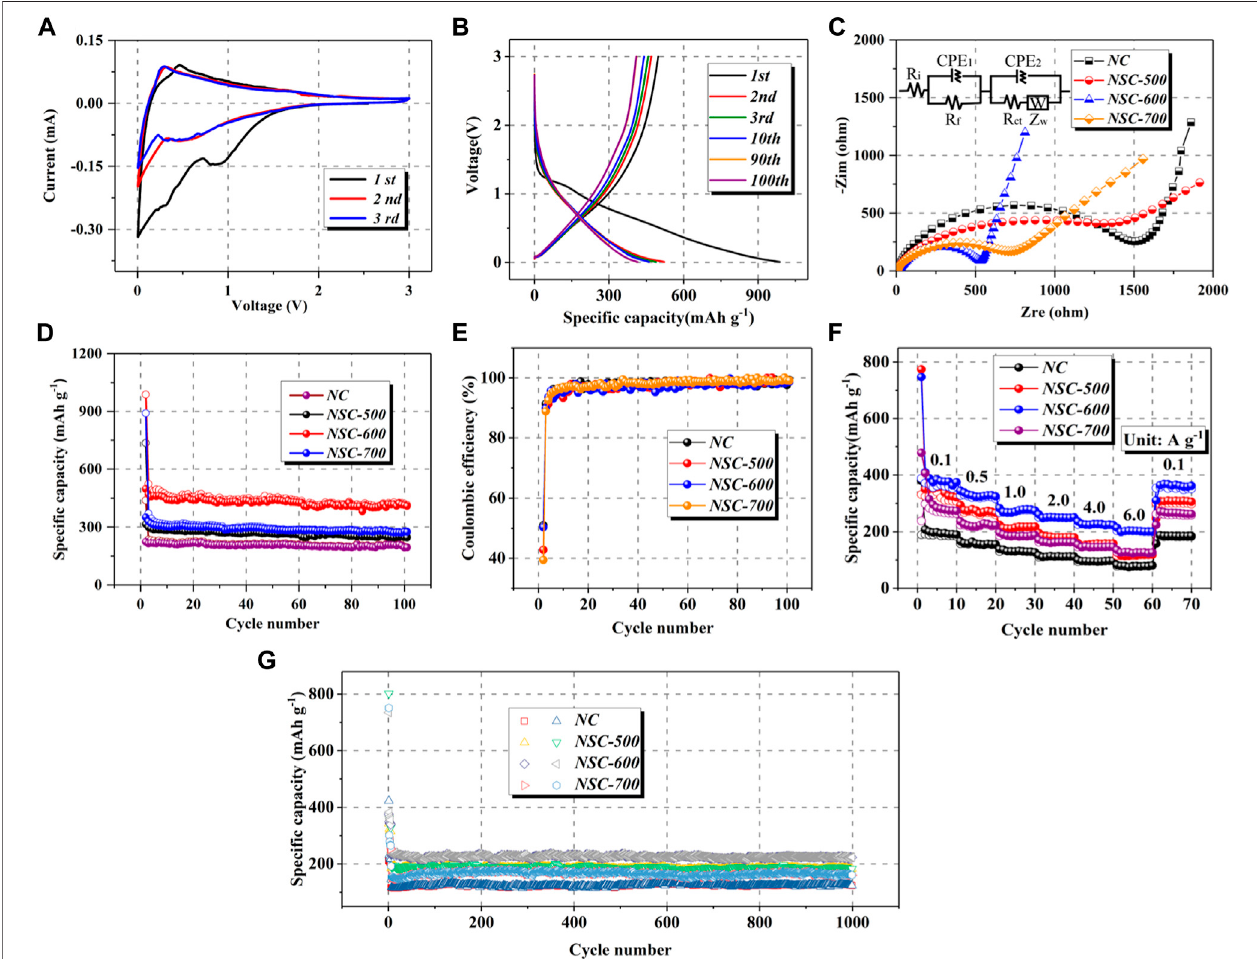
FIGURE 3 | (A) CV curves at 0.2 mV s − 1 and (B) discharge/charge pro fi les of different cycles at 0.1 A g − 1 for NSC-600 electrode. Electrochemical impedance spectra after fi ve cycles (C) , cycling performances [0.1 A g − 1 , (D) ], Coulombic ef fi ciencies (E) , rate performance (F) , and long-term cycling performance [1.0 A g − 1 , (G) ] of NC, NSC-500, NSC-600, and